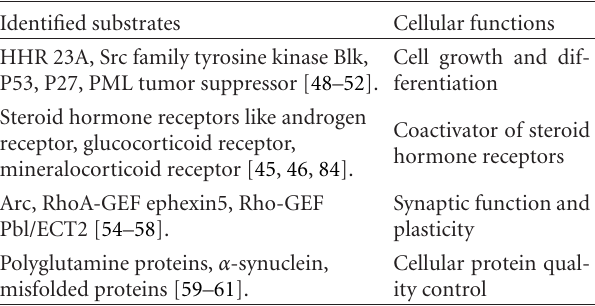
Table 2: Cellular functions regulated by